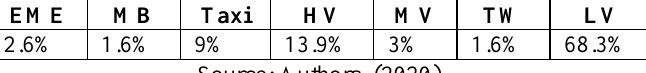
Figure 7: Vehicle, accident and fatality relationship Table 4: Vehicle types involved in accident.